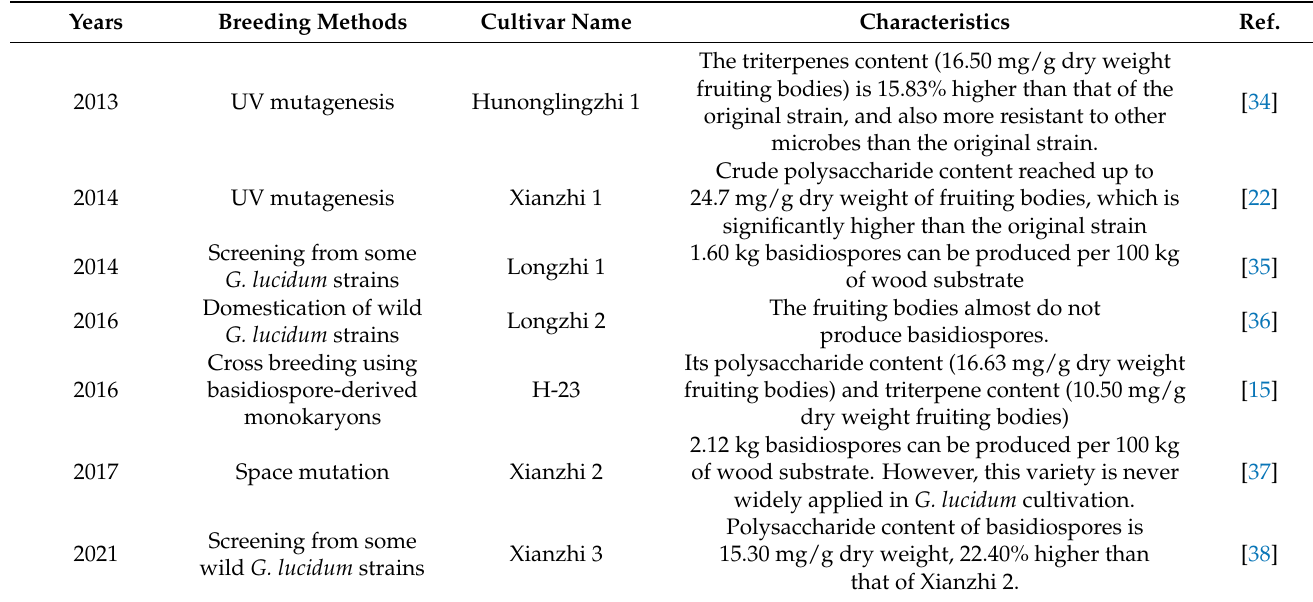
Table 7. Comparison with recent Ganoderma